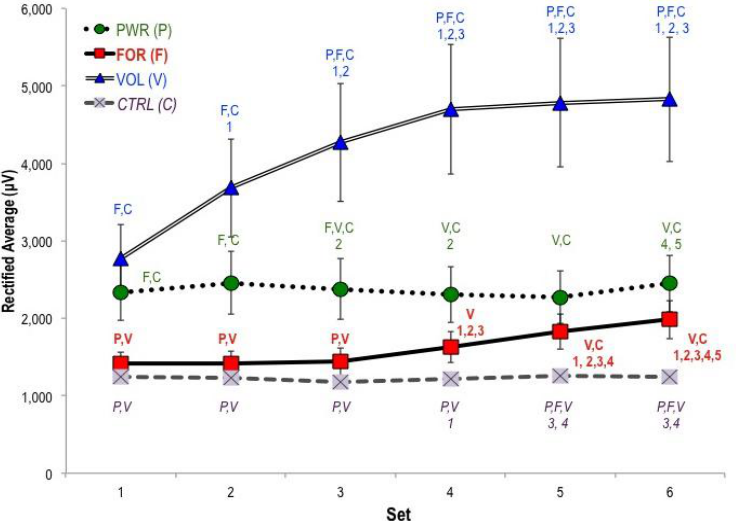
Figure 1. Changes in primary motor activity (C3, CZ, C4) across six sets. By Set 4,